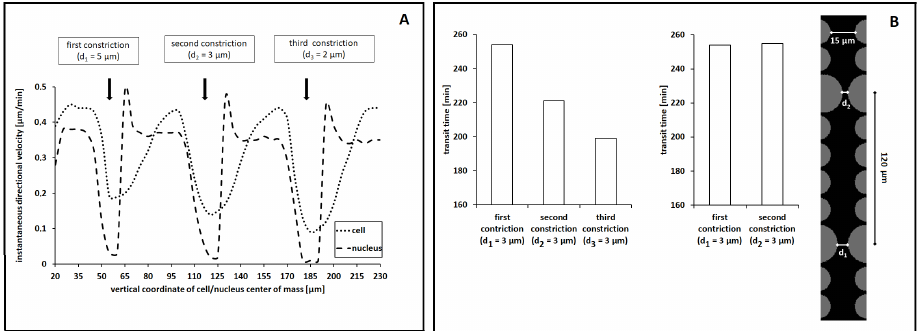
Figure 9. Quantification of cell migratory behavior in the case of reproduction of the device developed in [18]. ( A ) Time evolution of the instantaneous directional velocity of the cell, v η , and of its nucleus, v N , in the case of enhanced elasticity of the intracellular organelle, given by ν N = 0.7. In the graph, each value is the mean over 10 simulations. We have not plotted error bars, to avoid unnecessary graphical overcomplication. However, standard deviations were very small (of the order of 10 − 2 ). ( B ) Transit time, i.e., time needed by the cell to overcome a constriction, in the case of a channel characterized by three ( left ) or two ( right ) equal pores (each 3 µ m-wide). In the latter case, the two constrictions were largely-spaced, as shown in the inset reproducing the employed domain. In both plots, values were calculated over 100 numerical realizations. We recall that the initial diameter of the cell nucleus was d N = 16 µ